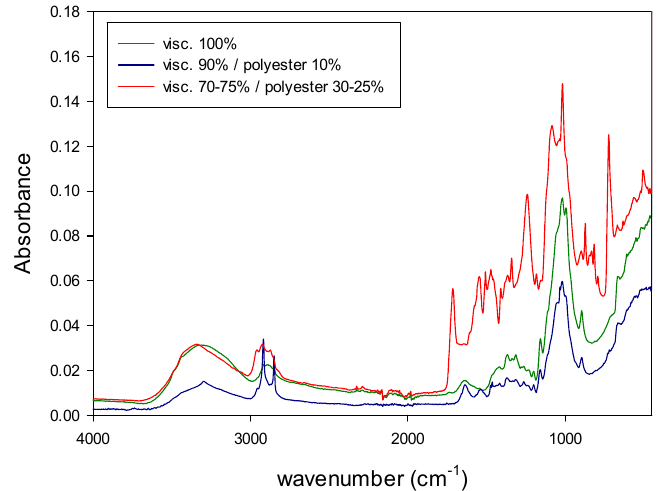
Figure 7. MIR spectra of binary mixtures of viscose/polyester.